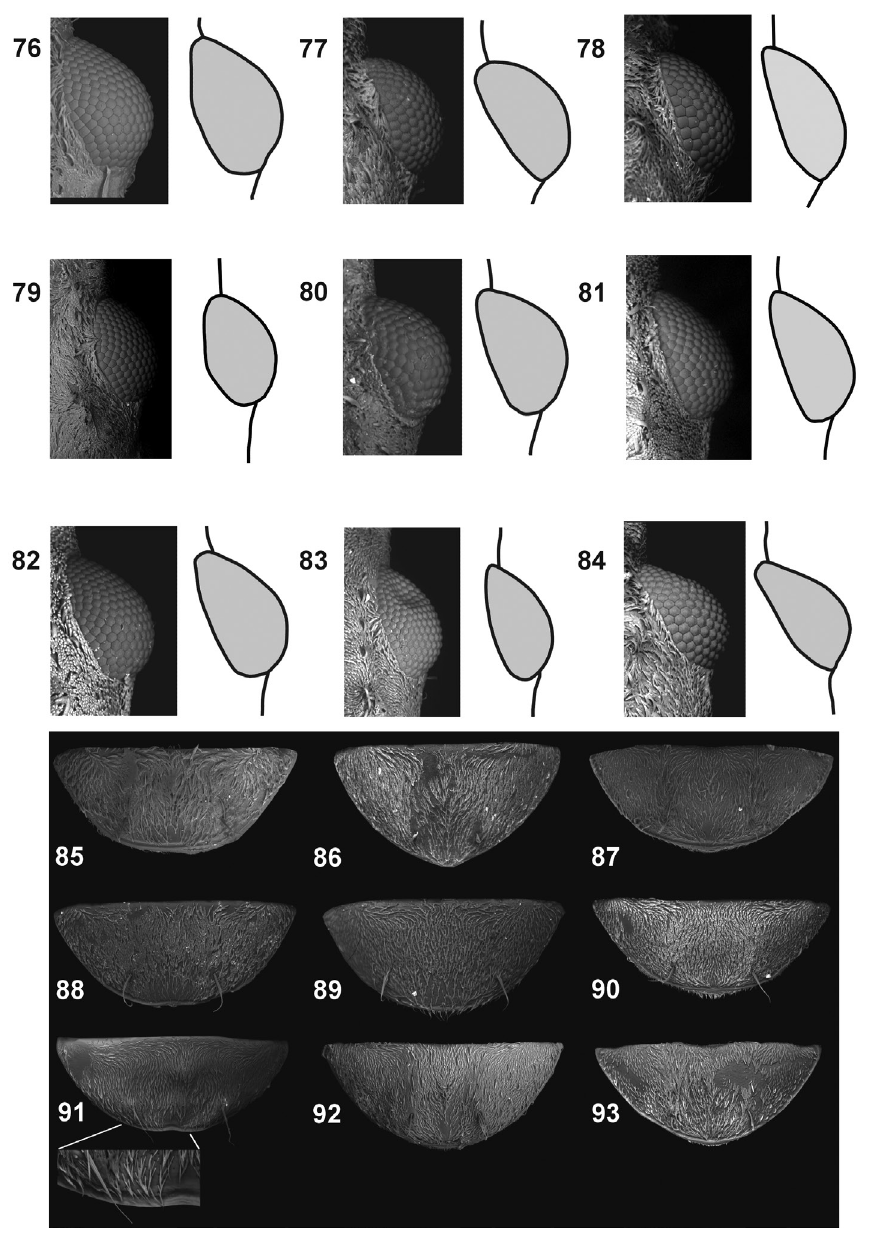
Figures 76–93. Outline of the eye, dorsal view: 76 C. farinosus Perr., male 77 C. fundatus sp. n., male 78 C. gibbus sp. n. 79 C. malleus sp. n. 80 C. minimus sp. n. 81 C. rutai sp. n. 82 C. szoltysi sp. n. 83 C. torosus sp. n. 84 C. turbidus sp. n. Last ventrite: 85 C. farinosus Perr., male 86 C. fundatus sp. n., male 87 C. gibbus sp. n., male 88 C. malleus sp. n., male 89 C. minimus sp. n., female 90 – C. rutai sp. n., male 91 C. szoltysi sp. n., female 92 C. torosus sp. n., male 93 C. turbidus sp. n.,